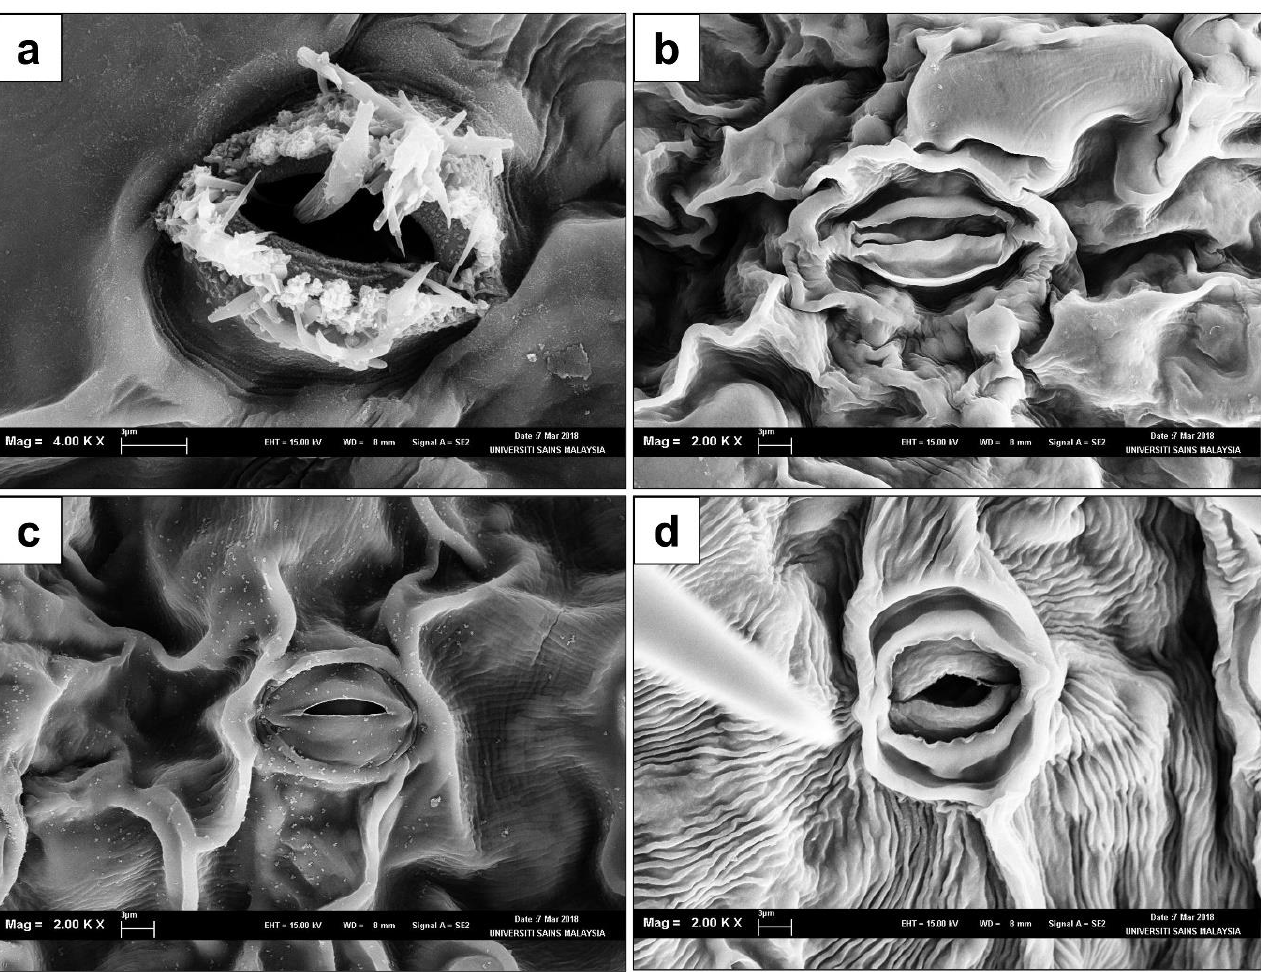
Figure 4. Scanning electron microscopy images of leaves of Ficus carica cv. “ Violette de Solliès ” pre- and post-acclimatization: ( a ) in vitro leaf ; ( b ) 20 days after acclimatization; ( c ) 40 days after acclimatization; ( d ) field-grown plant.